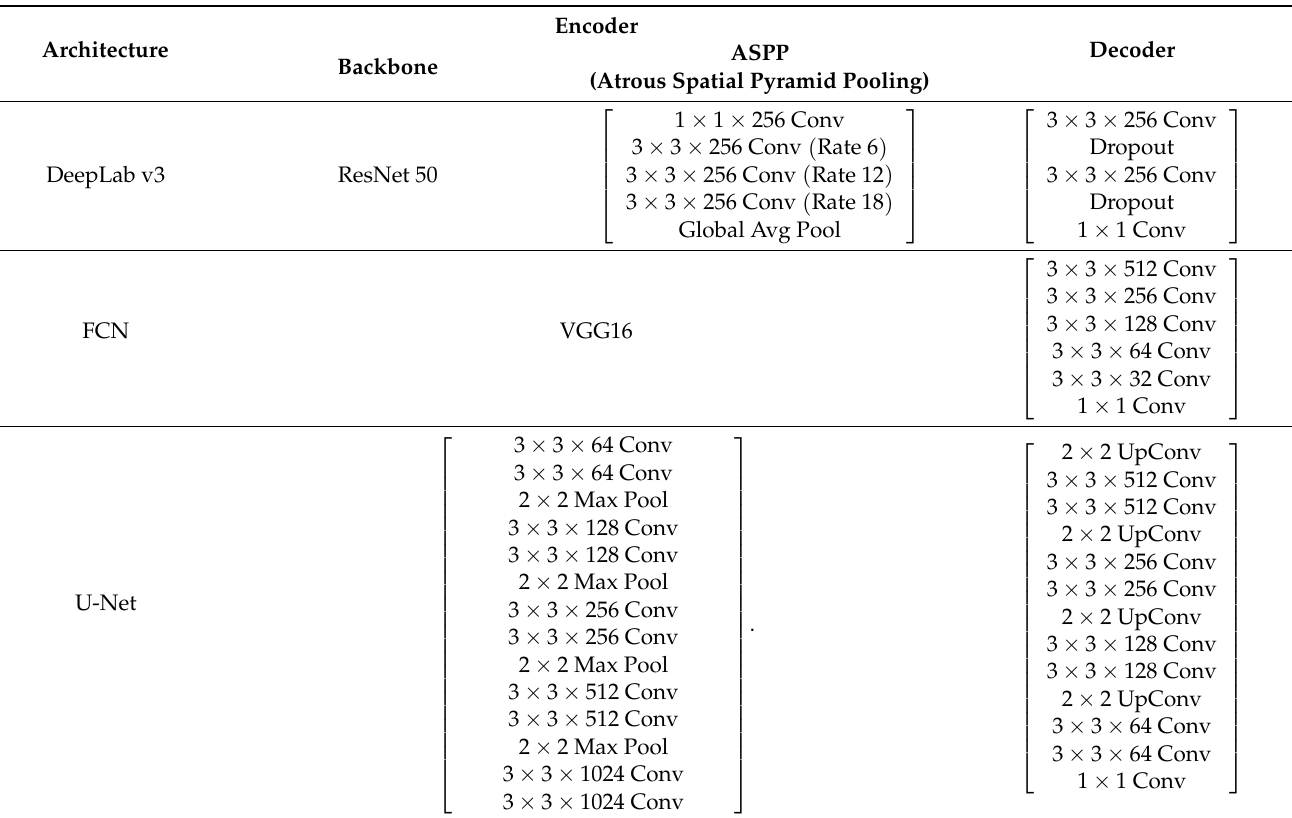
DeepLab v3 ResNet 50